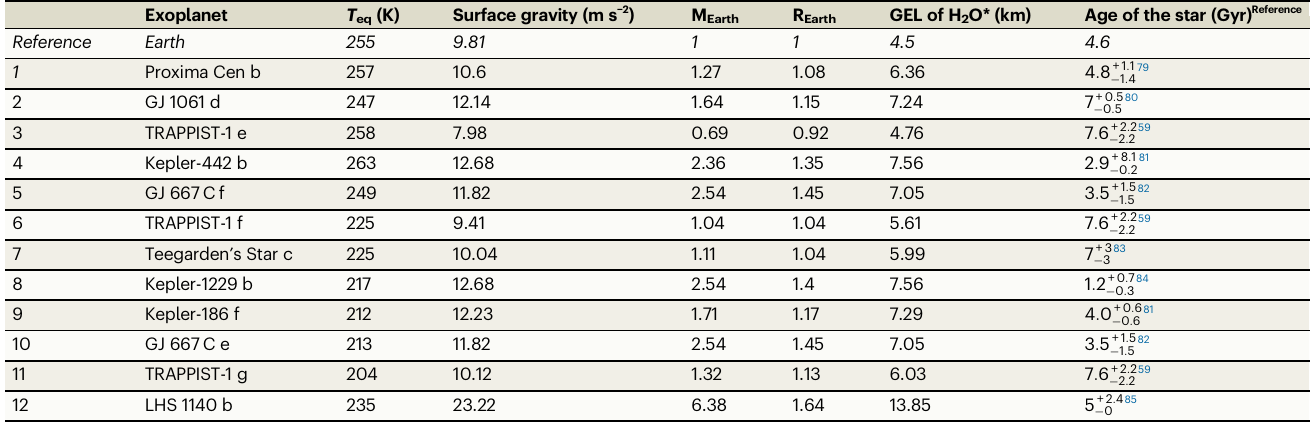
*Global Equivalent Layer (GEL) of H2O assumingEarthlikeWMF